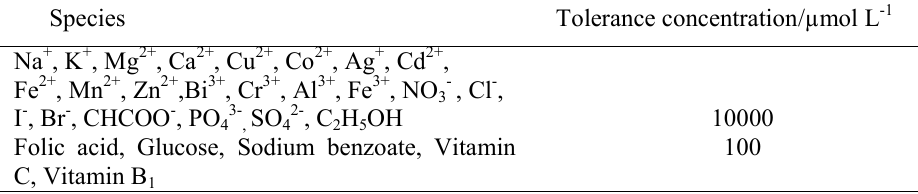
Table 4. Maximum tolerance concentrations of some species for determination of SMX and TMP.